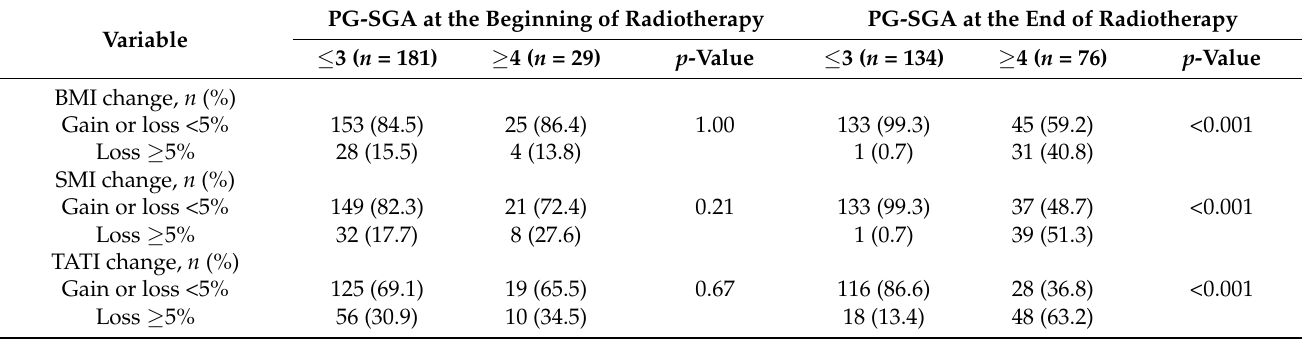
Table 3. Body composition change groups after treatment by PG-SGA.